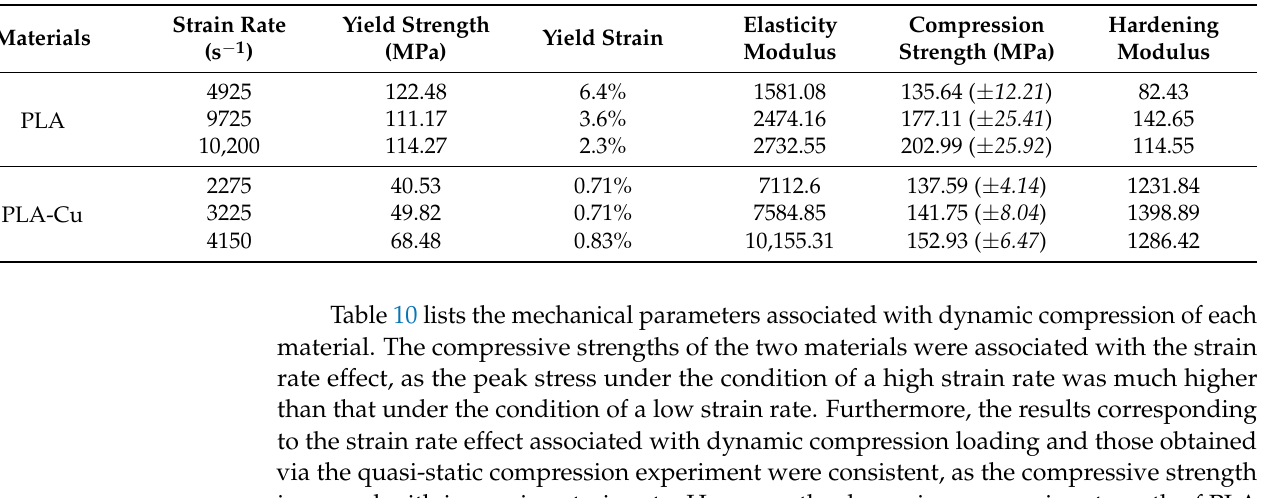
stage and an increase in the dynamic elastic modulus of the material. Table 10. SHPB experimental scheme. Table 10. SHPB experimental